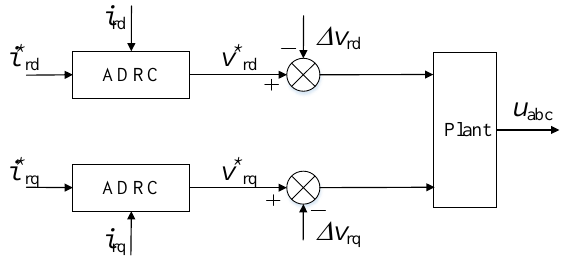
Figure 7. RSC control structure with ADRC.